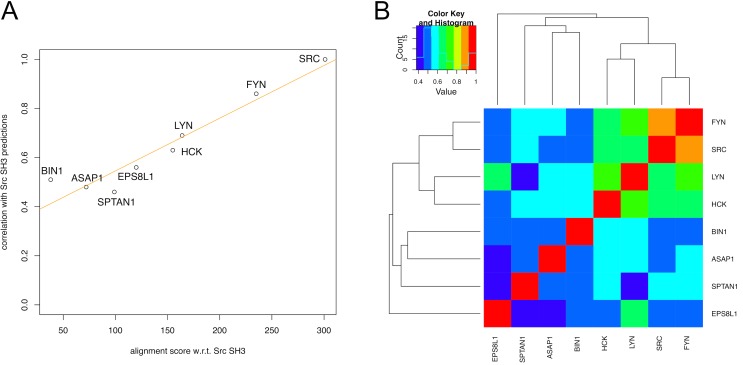
Analysis aimed at showing the degree of conservation of the predictions across the different SH3 variants and its relationship with respect to evolutionary events.A) Scatter plot showing the linear correlation between the alignment scores of each SH3 domain with Src SH3 (x-axis) and the Pearson’s correlation between the rankings produced for each SH3 domain and Src SH3 (y-axis). The regression line is displayed in orange. The Pearson’s correlation between the x- and y-axes values is equal to 0.96. B) Heat map showing the pairwise correlation (Pearson’s correlation coefficients) between the residue rankings obtained for the different SH3 variants (see Materials and Methods). Complete-linkage hierarchical clustering is applied to the matrix of pairwise correlations and the resulting dendrogram is shown on top together with a legend explaining the color-coding.